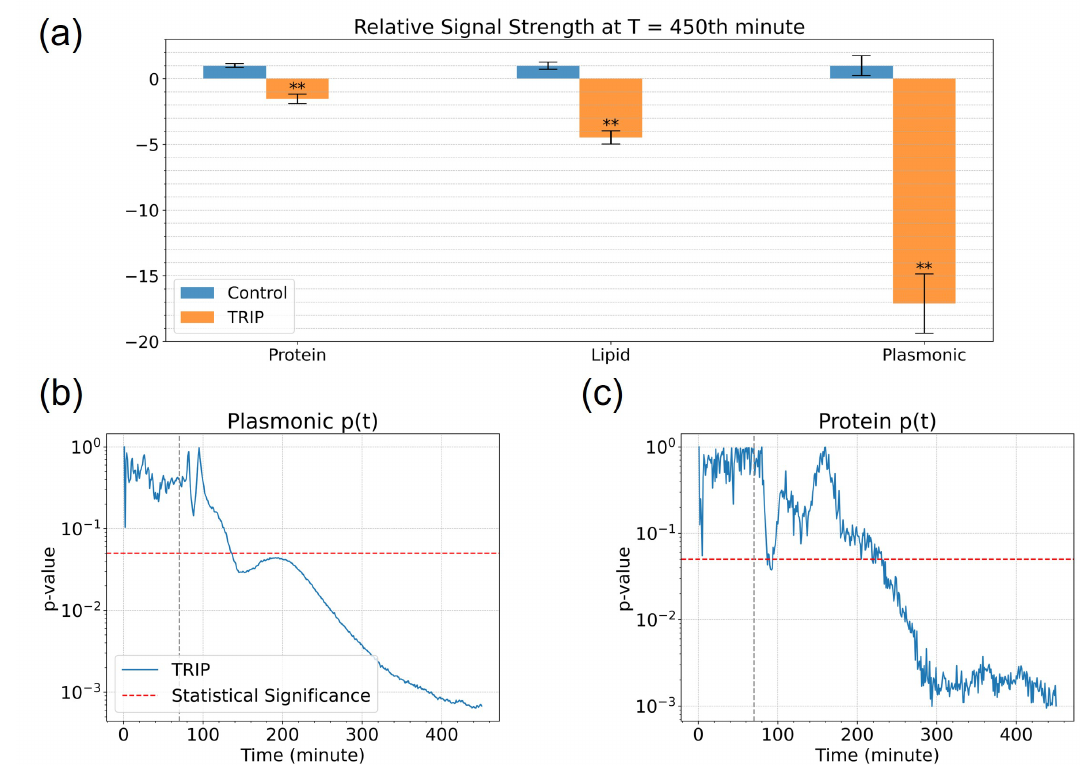
Figure 5. ( a ) Relative change in signal strength between t = 0 min to t = 450 min ( t final ) in three spectral windows, normalized to the control group. **: p ≤ 0.001. The TRIP-treated ( C TRIP = 5.0 µ M) group showed statistical significance in the protein, lipid, and plasmonic (i.e., refractive index) signals compared to the control. ( b ) p -values of the TRIP treatment at different times as seen through the MEIRS plasmonic resonance signal. The TRIP-treated cells showed the earliest statistically significant difference through p -value at around t = 140 min. Initial drug arrival: t 0 = 70 min (vertical dashed line). Statistical significance: p = 0.05 (horizontal red dashed line). ( c ) p -values of the TRIP treatment at different times as seen through the MEIRS protein vibration signal. The TRIP-treated cells showed the earliest statistically significant difference through p -value in the protein signals at around t = 220